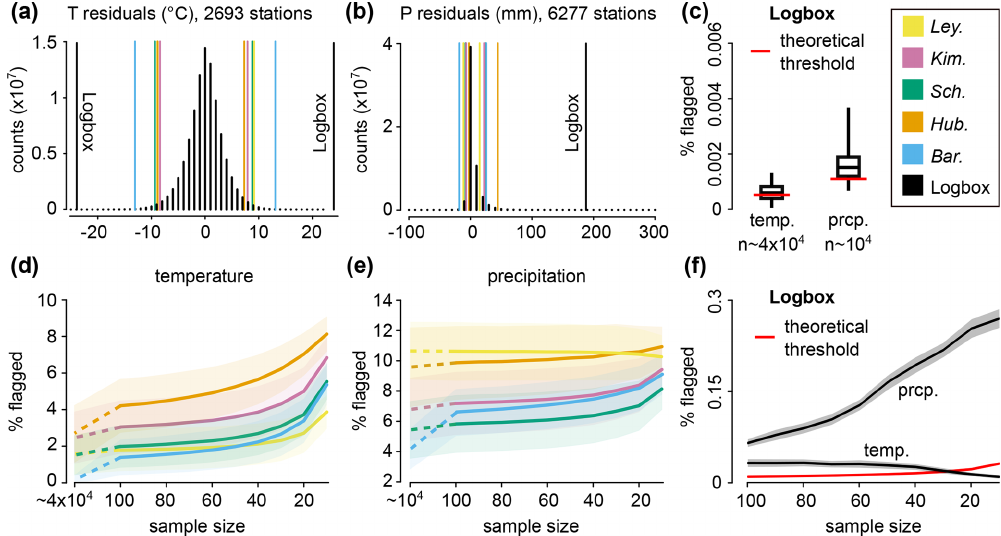
Figure 2. Comparison between six outlier detection methods performed on two sets of residuals (temperature and precipitation) obtained from weather stations with daily measurements over at least 100 years. The two histograms (a, b) represent aggregated residuals from all stations (for visualization purpose only) and show counts with at least 100 daily occurrences, with the median of the lower/upper threshold displayed for each method. For the methods Ley. (Leys et al., 2013), Kim. (Kimber, 1990), Sch. (Schwertman et al., 2004), Hub. (Hubert and Vandervieren, 2008), and Bar. (Barbato et al., 2011), the mean percentage ( ± 1 SD) of flagged data is shown for sample sizes varying from 10 to 100, and for all available points per station ( n ∼ 4 × 10 4 for the temperature and n ∼ 10 4 for the precipitation, panels d and e ). For Logbox (c, f) , this percentage is calculated by pooling all points, and the variability is estimated with a random resampling of stations (see Method). The theoretical threshold is the expected percentage of erroneously flagged outliers ( p theo = f (n) × 100